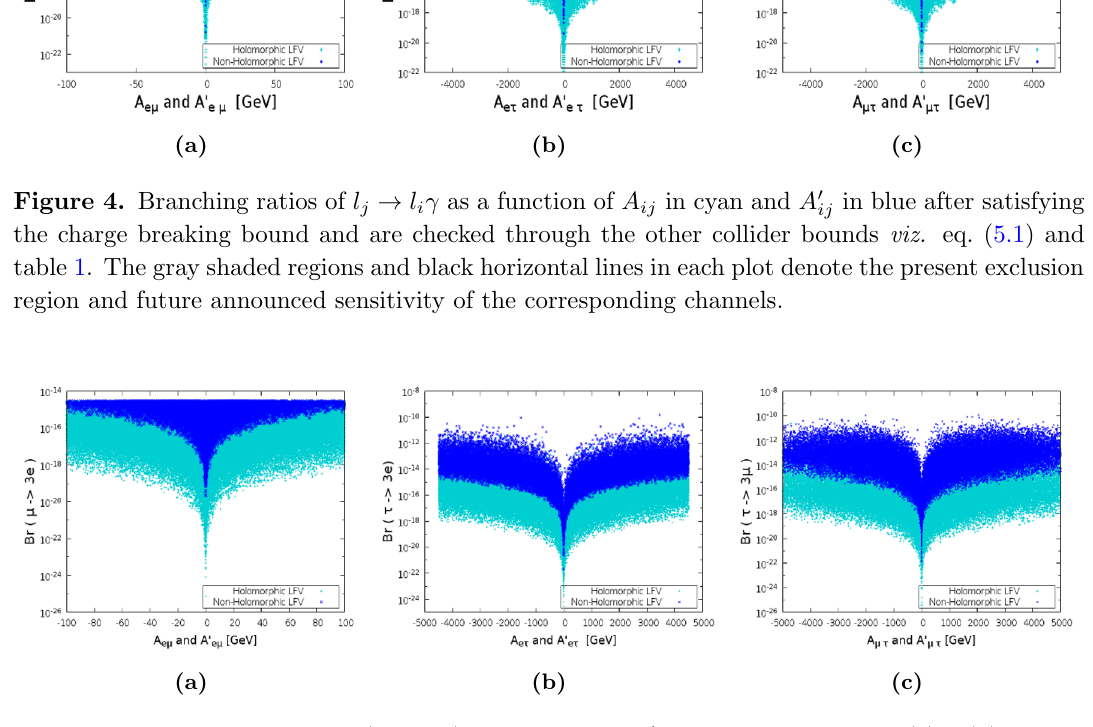
Figure 5. The variation of Br ( (cid:22) Br ( (cid:28) 3 e ) with A e(cid:28) and A 0 ! through the checks of (5.1) and table 1, and after avoiding the overall charge breaking minima